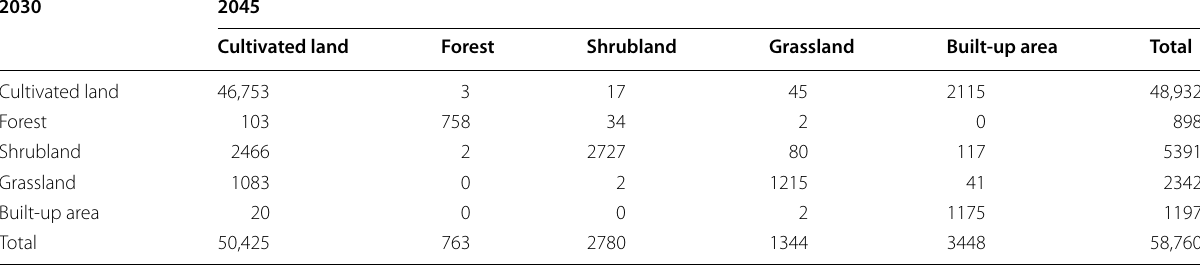
Table 13 Land use/land cover conversion matrix (ha) for the period 2030 and 2045 2030